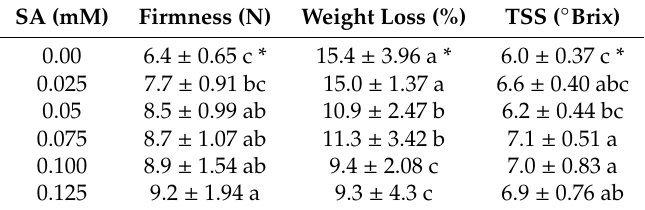
Table 2. Tomato fruit biophysical quality and weight loss as a ff ected by SA foliar